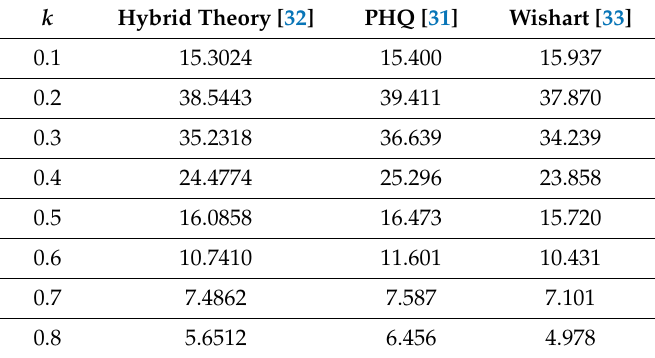
Table 6. Photodetachment cross-sections (Mb) of the ground state of H − . The outgoing electron has momentum k. The number of terms in the Hylleraas wave function for the bound state is 364. These results are compared with those obtained by Wishart [33]. k Hybrid Theory [32] PHQ